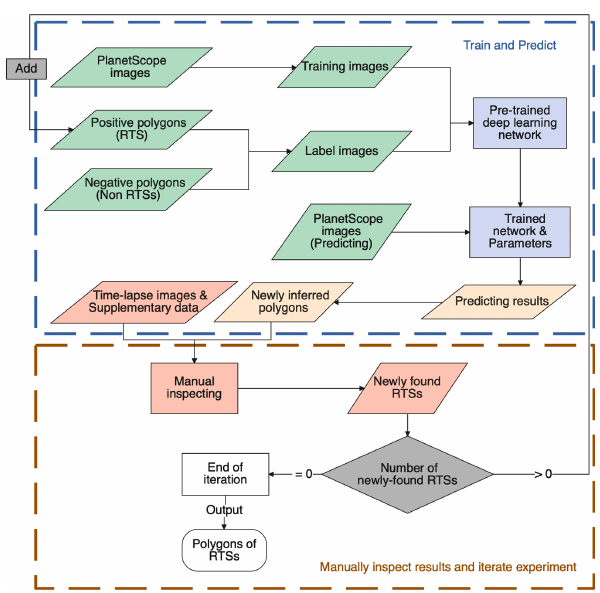
Figure 2. Workflow of the deep-learning-aided semi-automatic